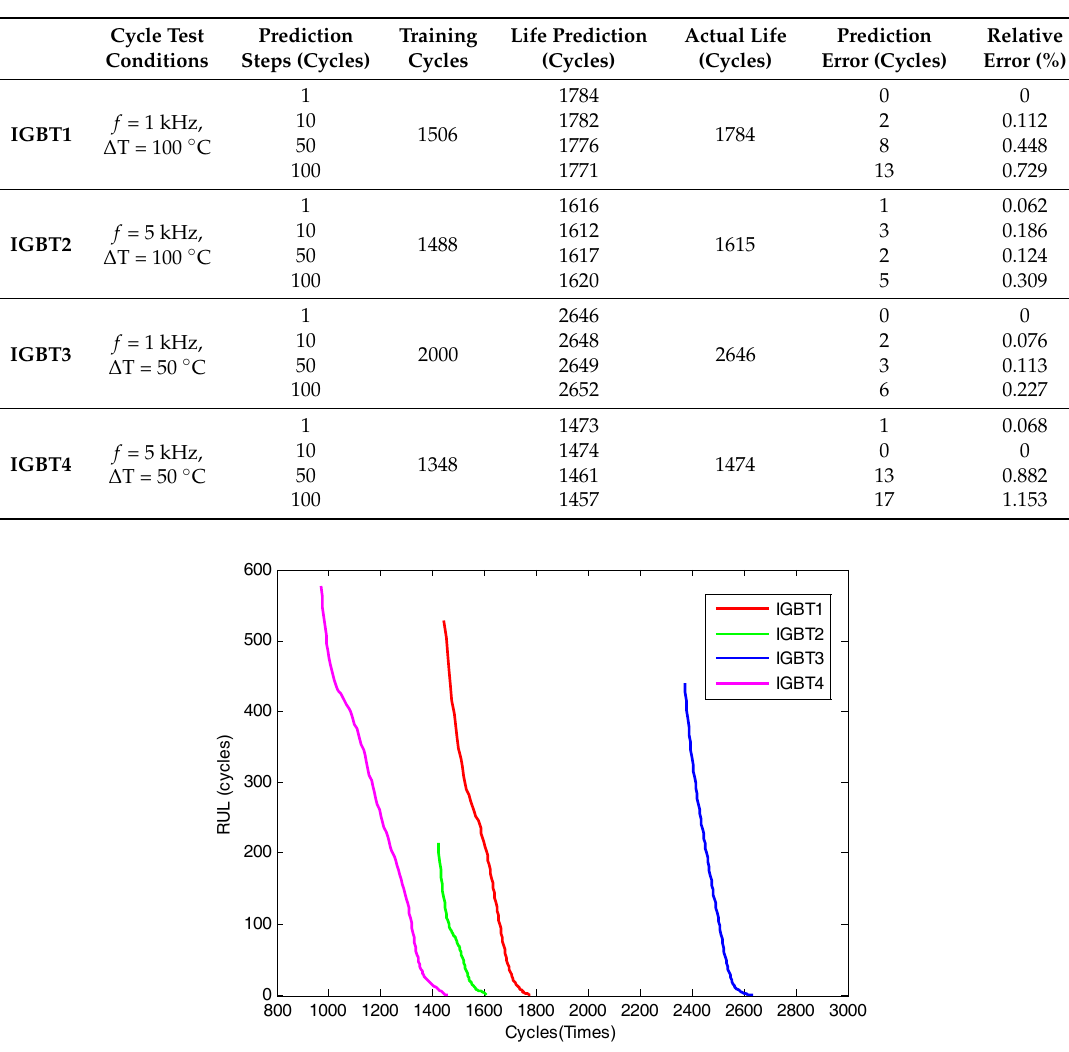
Table 7. The life prediction error result for each IGBT experimental dataset at different prediction steps.